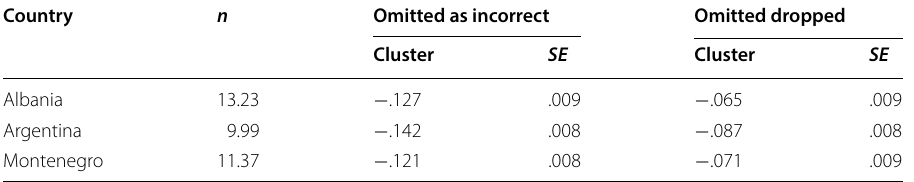
Table 7 The Average number (n) of omitted items and comparison of position effects in PISA 2012 mathematics between the different treatments of nonresponses due to omission in three selected countries Country n Omitted as incorrect Omitted dropped Cluster SE Cluster SE Albania 13.23 .127 .009 .065 .009 − − .008